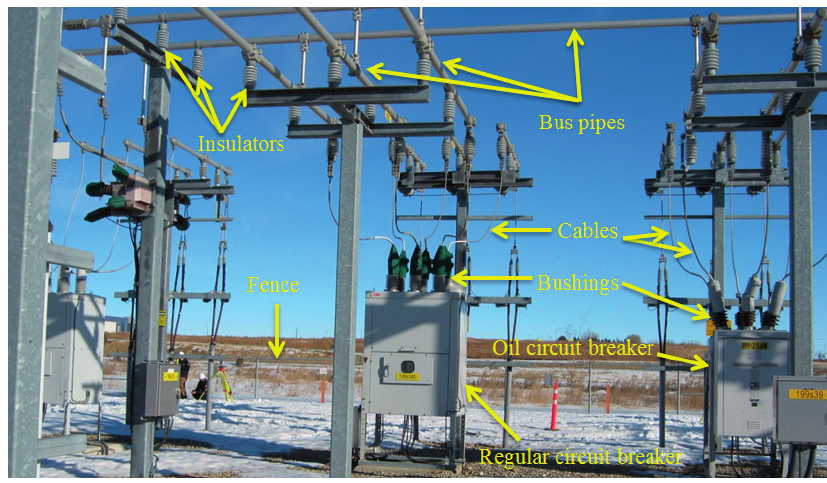
Figure 1. Components of an electrical substation site.